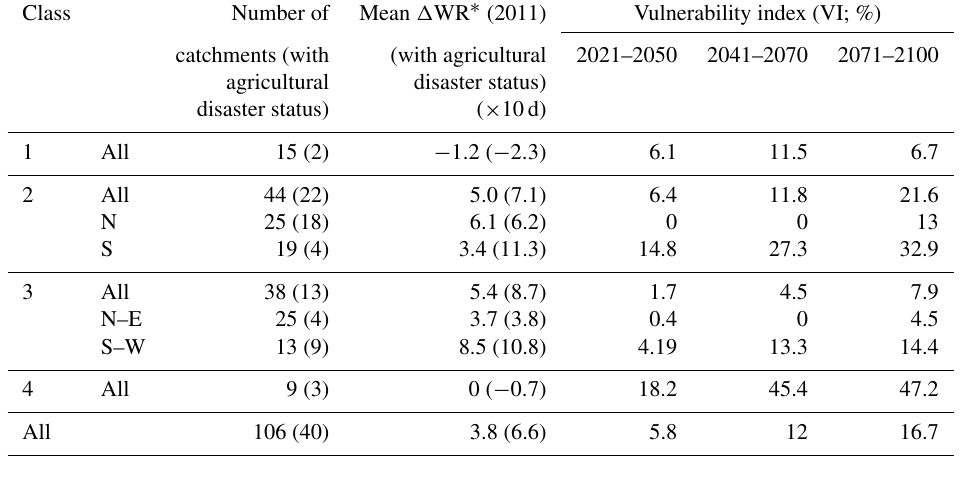
Table 7. Summary statistics for the mean anomaly (cid:49) WR ∗ (2011) and for the measure of vulnerability (VI) estimated at the regional scale.